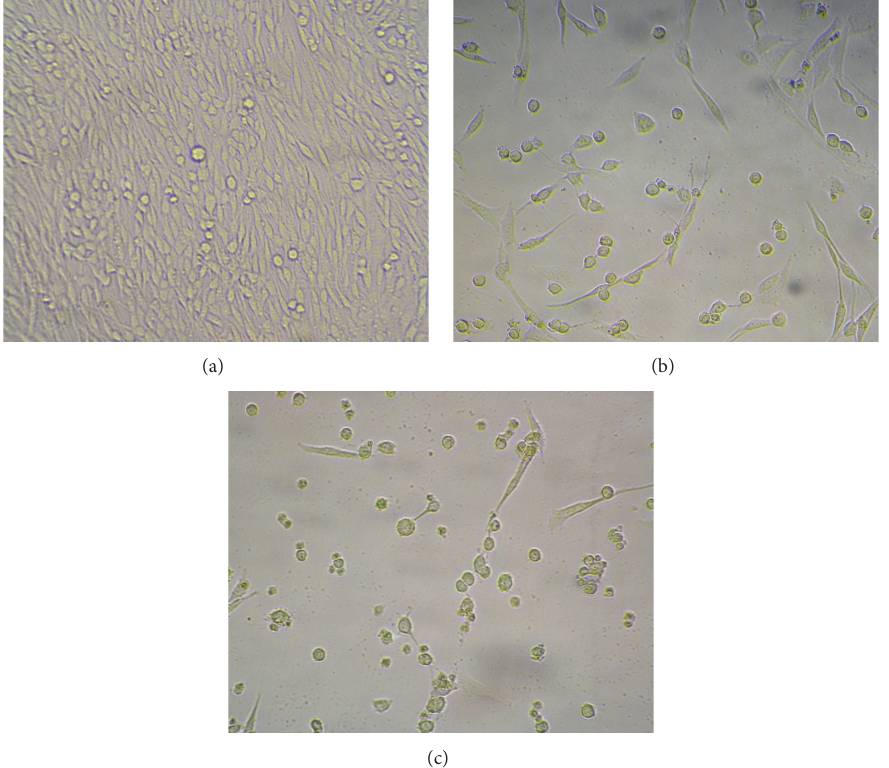
Figure 2: Morphological changes of C6-TK and C6-sr39TK cells 72 hours after ganciclovir (GCV) administration ( × 200). As compared with control C6 cells (a), C6-TK (b) and C6-sr39TK cells (c), especially the latter, showed evident morphological changes that were characteristic of growth inhibition/cellular death after GCV treatment: cells became round and shrunk, lost their protuberances, and detached from the floor of culture